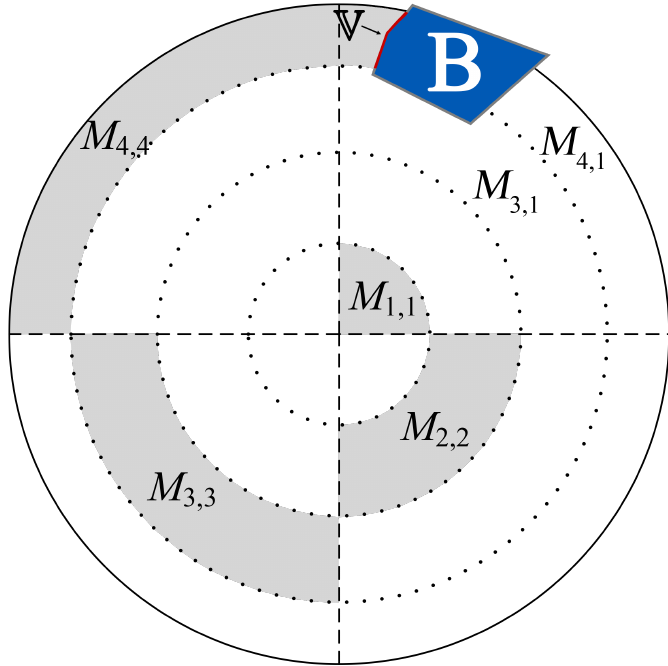
Figure 12. Primary divisions with irregular